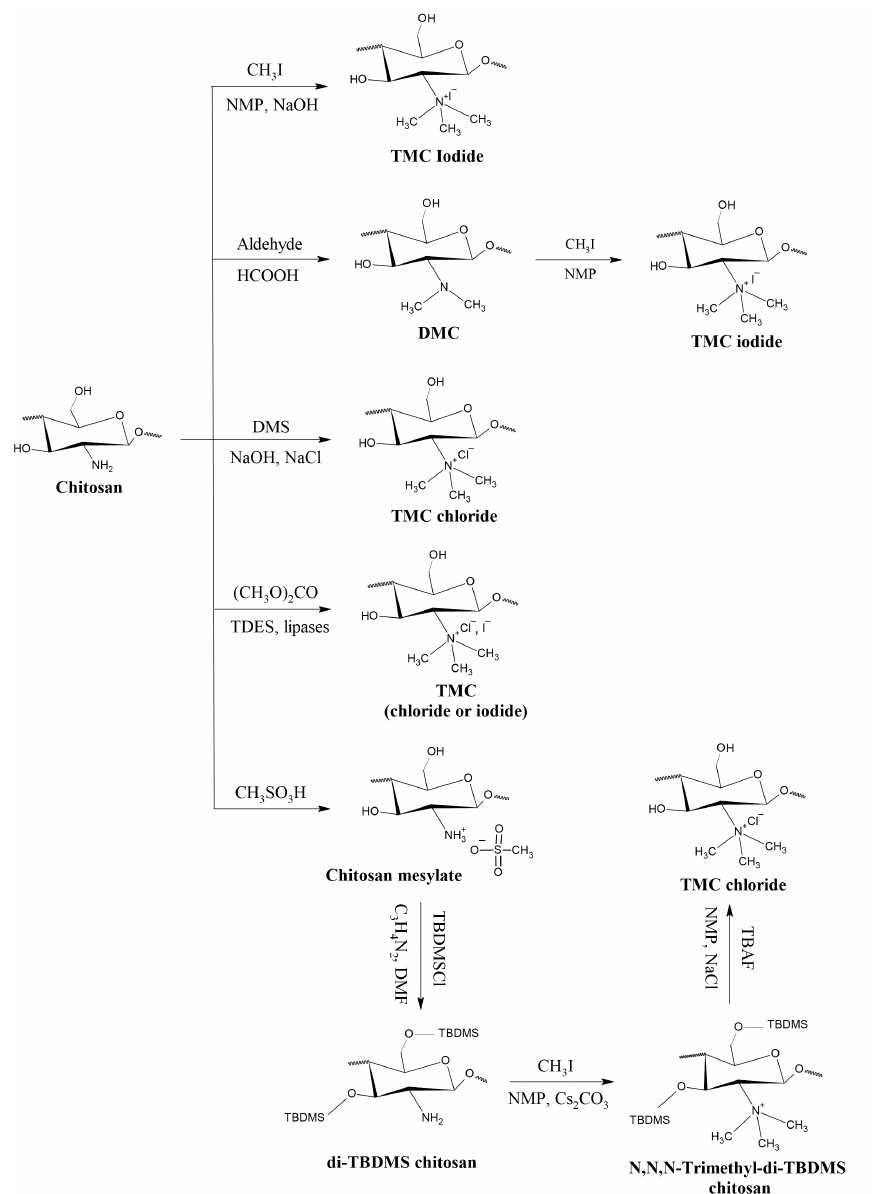
Figure 2. TMC preparation methods